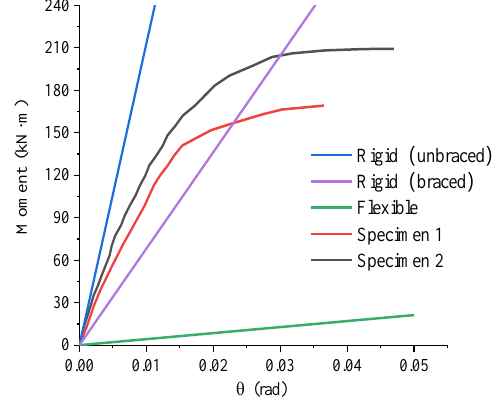
Figure 18. Sti ff ness classification. Figure 18. Stiffness classification. Figure 18. Stiffness classification.